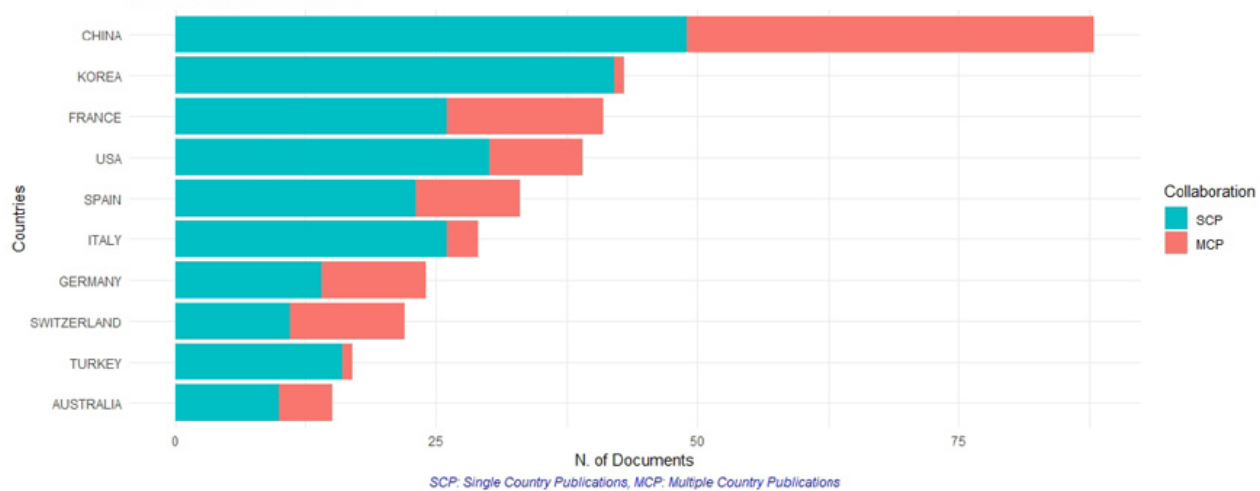
Figure 2. Top 10 countries with the most publications.